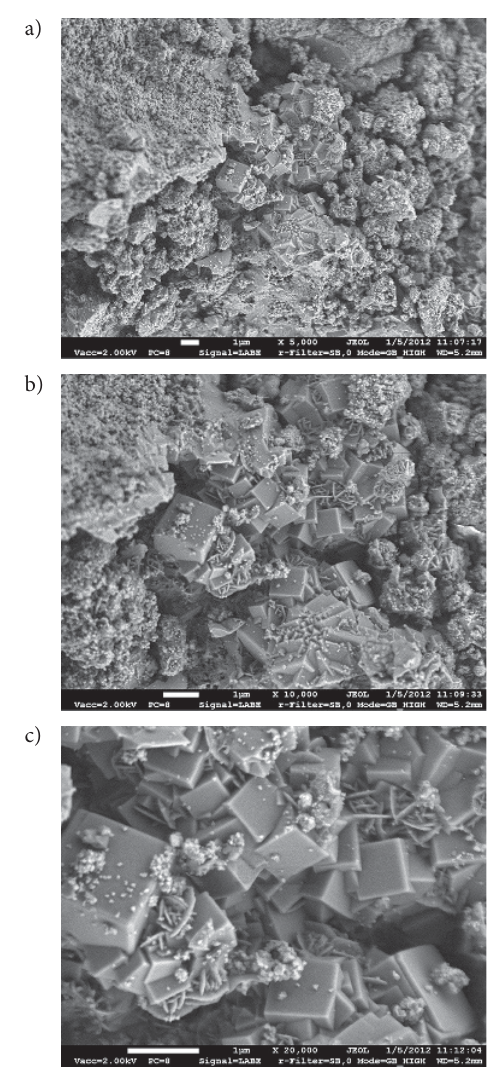
Fig. 2. SEM images of modification A synthetic zeolite production waste: a – the view enlarged produced from AIF 3 5000 times; b – the view enlarged 10 000 times; c – the